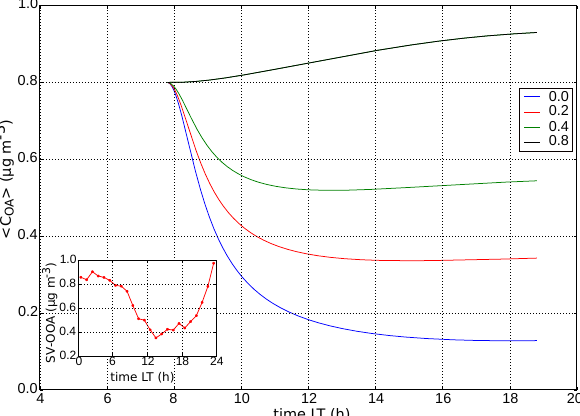
Fig. 6. Organic aerosol concentration C OA for the case study, in- cluding the sensitivity to different FT background OA concentra- tions (0.0, 0.2, 0.4, 0.8µgm − 3 ). The inset shows the diurnal cycle of the measured SV-OOA-concentration, averaged over 15